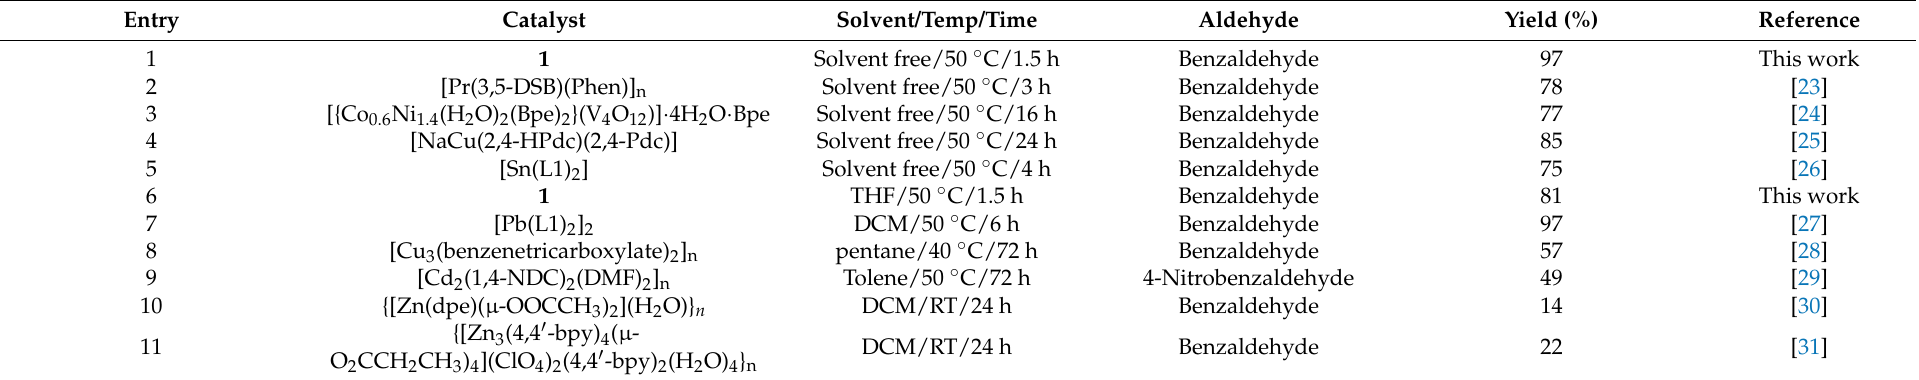
Table 3. A comparison of catalytic activity of different reported coordination polymers in the cyanosilylation of aldehydes with trimethylsilyl cyanide